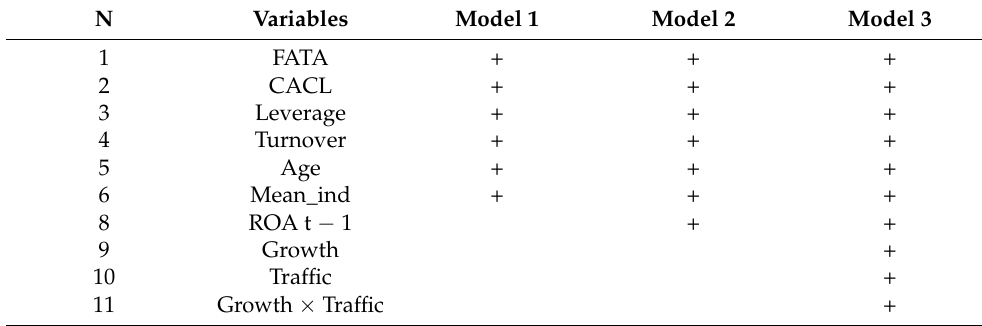
Table 2. Regression models and their variables.